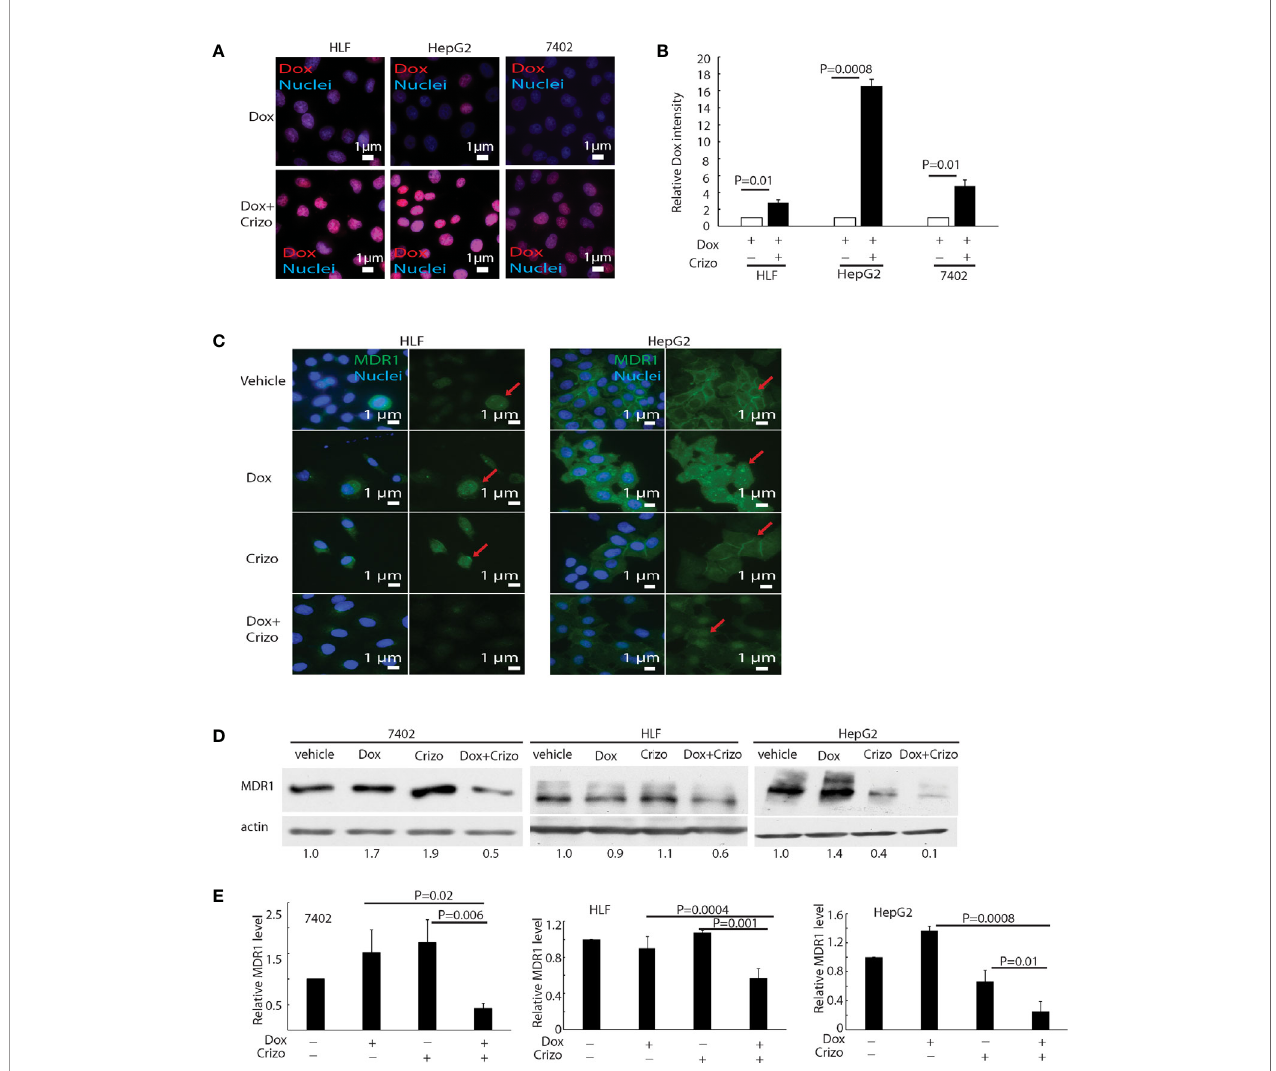
FIGURE 3 | Crizo plus Dox induce Dox nuclei accumulation via reducing MDR1 protein levels. (A) Crizo (5 m M) plus Dox (0.85 m M) treatment of HCC cells resulted in more Dox (red) accumulation in the nuclei (blue) compared to Dox (0.85 m M) treatment only. Immuno fl uorescence pictures were taken after cells were treated for 24 hs. (B) Summary of three experiments showed that Dox plus Crizo resulted in signi fi cant more nuclei Dox accumulation. Open and fi lled in bar graphs represented the mean and standard deviation. (C) Immuno fl uorescence staining of MDR1 with speci fi c antibody revealed that Crizo (5 m M) plus Dox (0.85 m M) treatment mitigated MDR1 expression than vehicle, Dox (0.85 m M), or Crizo (5 m M) only treatment. Cells were treated for 24 hs and then fi xed for immuno fl uorescence staining. In HepG2 cells, Dox treatment seems changed the distribution of MDR1. (D) Signi fi cantly less MDR1 was detected from cell lysates made from HCC cells treated with Crizo (5 m M) plus Dox (0.85 m M) than from cells treated with vehicle, Dox (0.85 m M), or Crizo (5 m M) only. (E) Statistical analysis of three experiments showed that Dox plus Crizo resulted in signi fi cantly less MDR1 in HCC cells. Filled in bar graph represented the mean and standard deviation. Cells were treated for 24 hs before cell lysates were made and immunoblotted with antibodies speci fi c to MDR1 or actin. Nuclei were counterstained by DAPI. Relative immuno fl uorescence intensity or protein levels were determined with IMAGE J as speci fi ed. The experiments were repeated three times with similar results. P values were